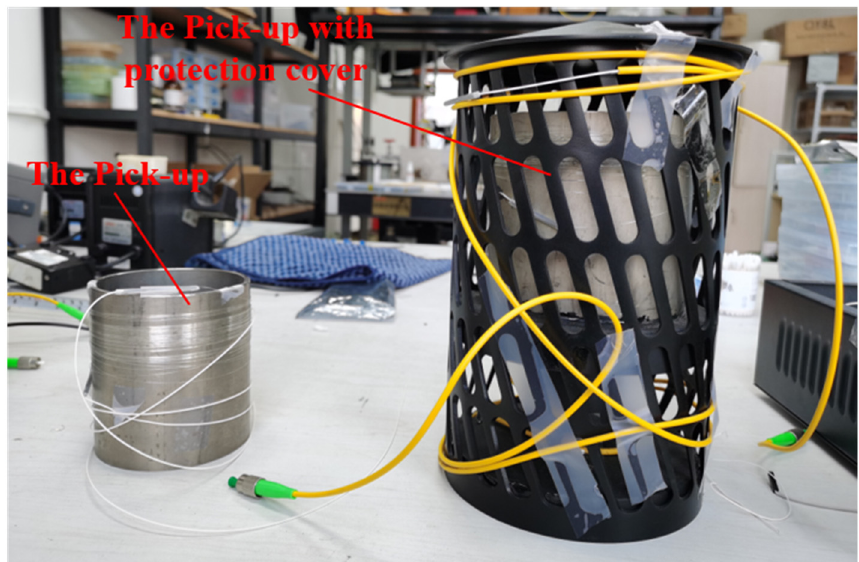
Figure 5. The photo of a titanium alloy pick-up.